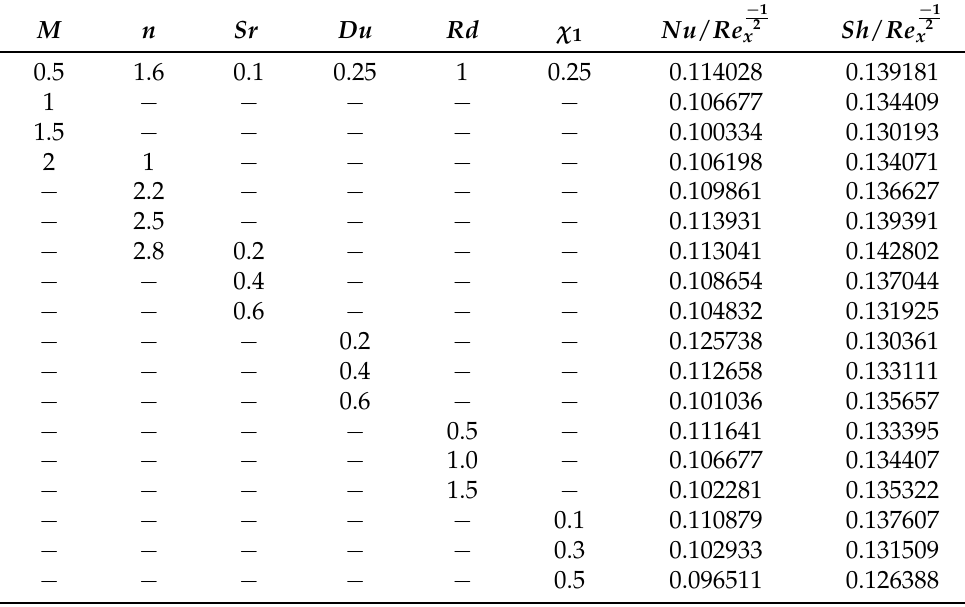
Table 5. Nu x , and Sh x in the case of